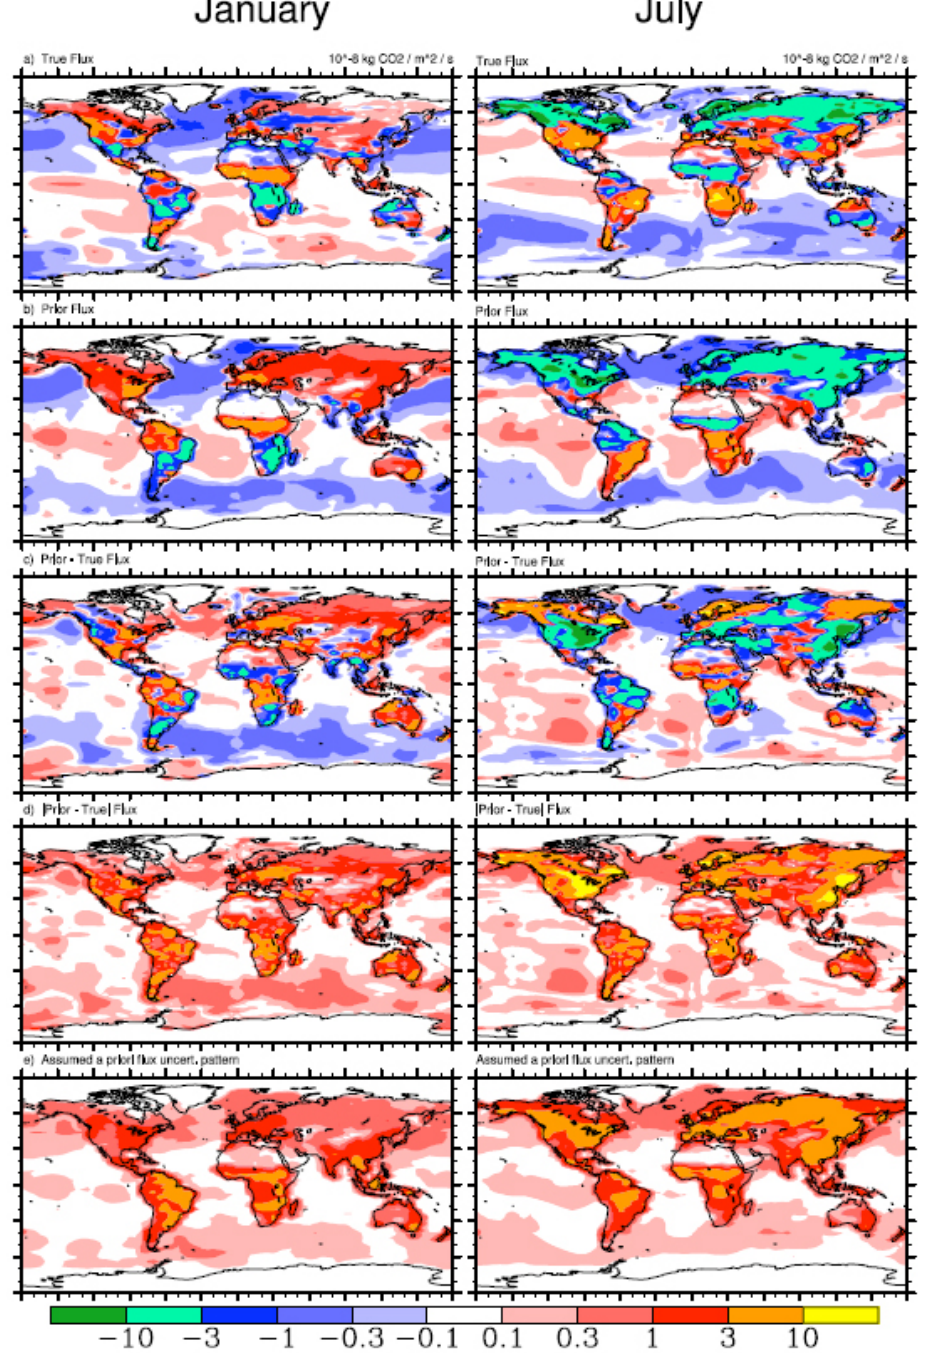
Fig. 2. January (left) and July (right) mean values for (a) the “true” surface CO 2 fluxes (LPJ land + NCAR ocean); (b) the a priori CO 2 fluxes (CASA land + Takahashi ocean); (c) the prior-truth flux difference; and (d) | prior-truth | . The values in (d) are used in the assumed a priori flux error covariance matrix for all experiments except Experiment 3, the mistuning experiment, which used the values in (e) . All in [10 − 8 kg CO 2 m − 2 s − 1